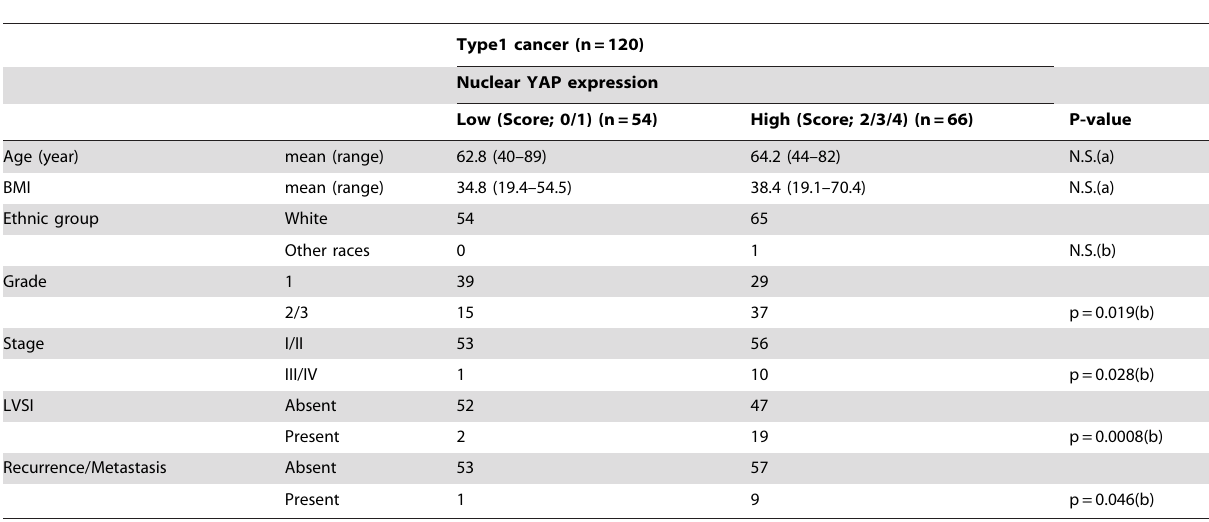
Table 2. Association of YAP expression in nucleus with clinicopathological factors in